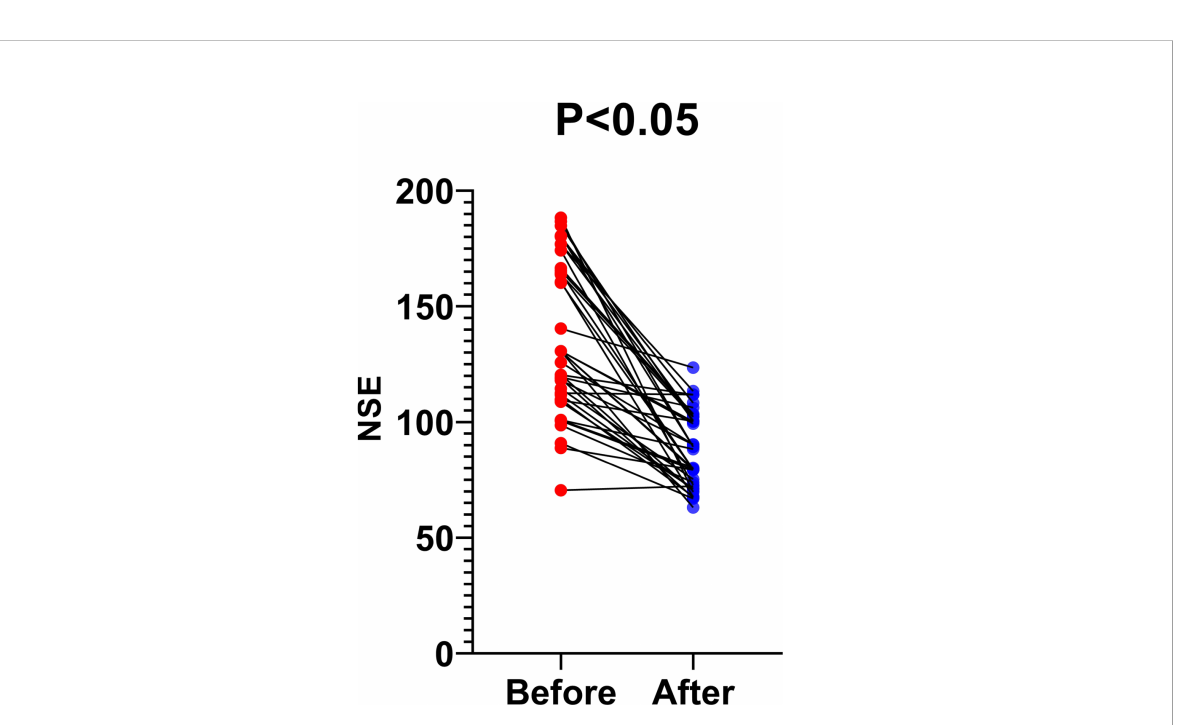
FIGURE 2 Changes in serum NSE levels after treatment for herpes zoster